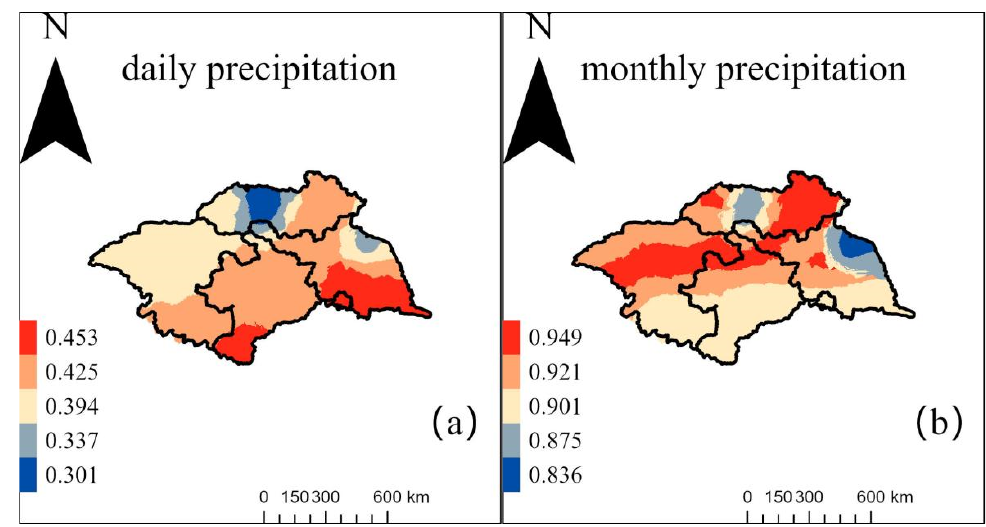
Figure 7. Spatial distribution of Spearman correlation coefficient ( ρ ) between PERSIANN-CDR and gauge observations at ( a ) daily and ( b ) monthly scale.